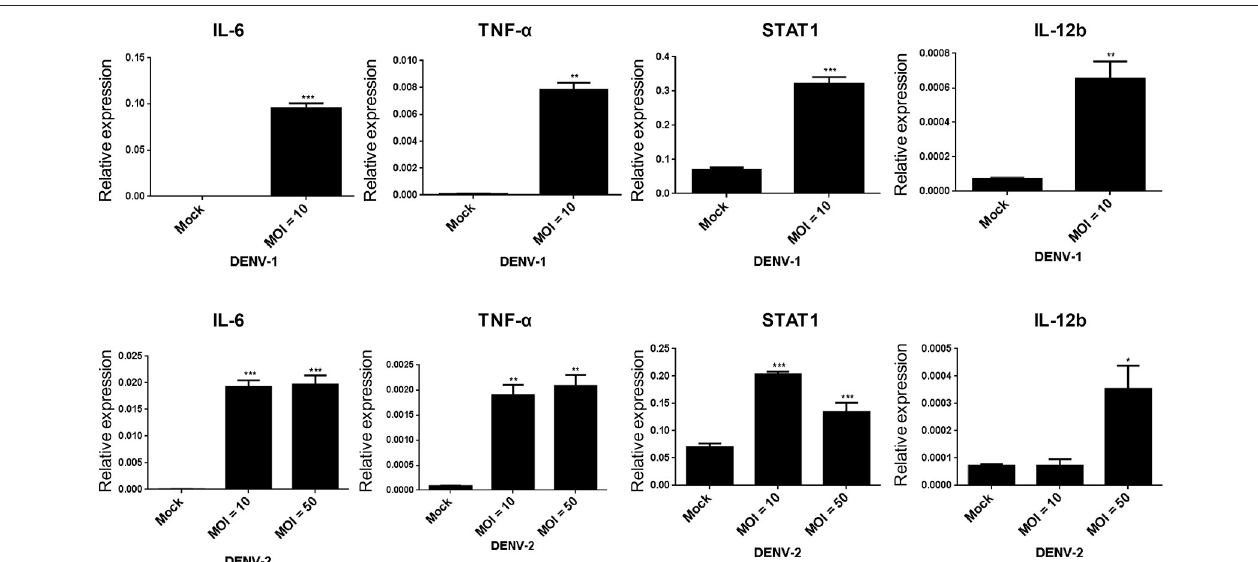
FIGURE 4 | DENV-1 and − 2 induce interleukin 6 (IL-6), tumor necrosis factor-alpha (TNF- α ), signal transducer, and activator of transcription 1 (STAT1), and IL-12b gene expression in HFDPCs. RT-qPCR of IL-6, TNF- α , STAT1, and IL-12b expression in HFDPCs infected with DENV-1 (MOI = 10) and DENV-2 (MOI = 10 and 50) for 4 days. The gene expression was normalized to GAPDH gene. Data are mean ± SD from three independent tests, * P < 0.05; ** P < 0.01; *** P < 0.005 vs. untreated